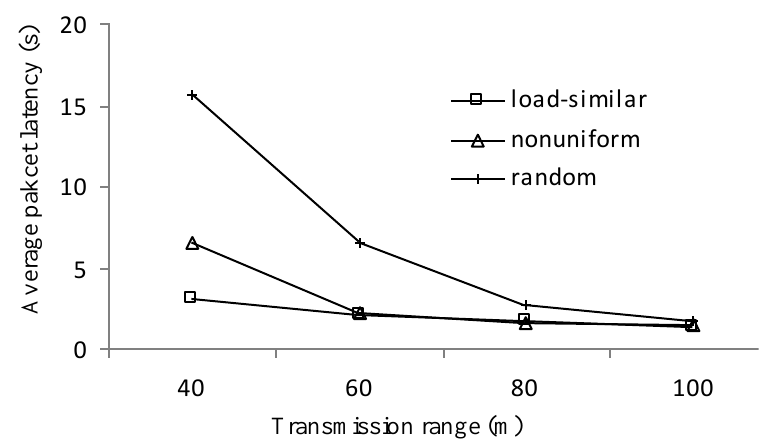
Figure 12. Average packet latency vs. r .